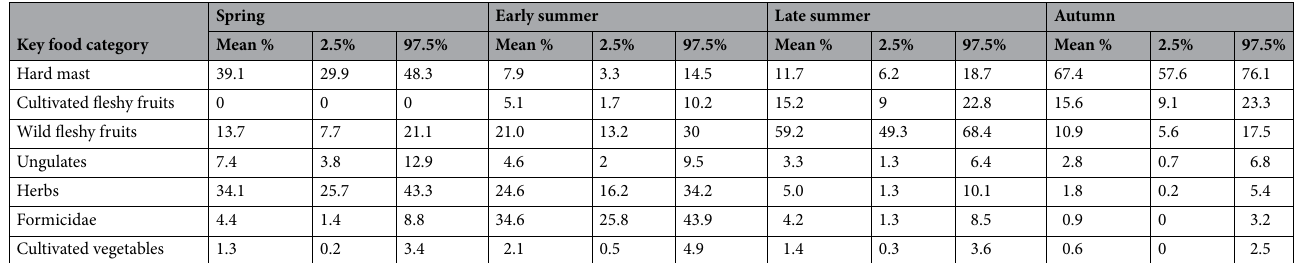
Table 4. Mixing model estimated dietary proportions of key foods categories for Apennine brown bears (Abruzzo Lazio and Molise National Park, central Italy, 2013–2014). Values are reported as mean probabilities and upper and lower 95% credibility intervals. Food categories are ordered in descending order relative to Autumn.